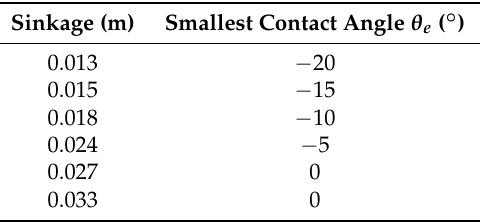
Table 4. Relationship between smallest contact angle θ e ( ◦ ) and sinkage.